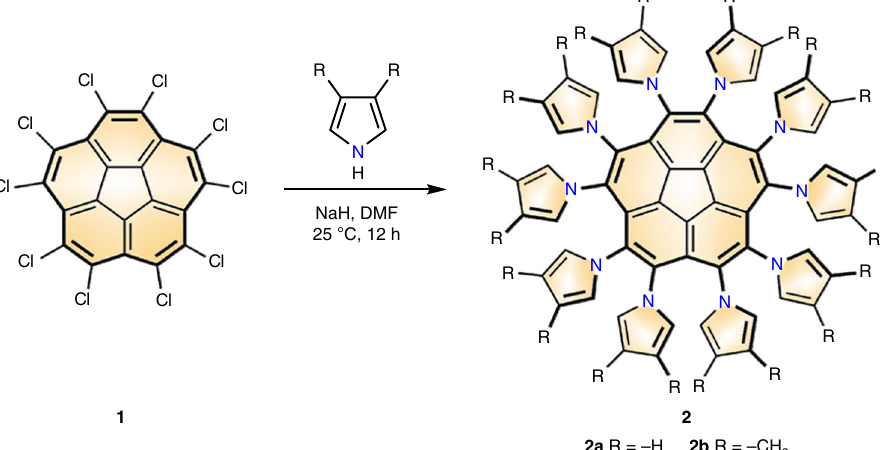
Fig. 1 Synthesis of decapyrrylcorannulene derivatives 2 from decachlorocorannulene 1. Conditions: NaH (60% oil dispersion, 2.0 mmol, 12 eq for 2a , 3.4 mmol, 20 eq for 2b ), pyrrole (2.0 mmol, 12 eq) or 3,4-dimethylpyrrol (3.4 mmol, 20 eq), decachlorocorannulene 1 (0.17 mmol, 1 eq), 25 °C, 12 h. DMF: